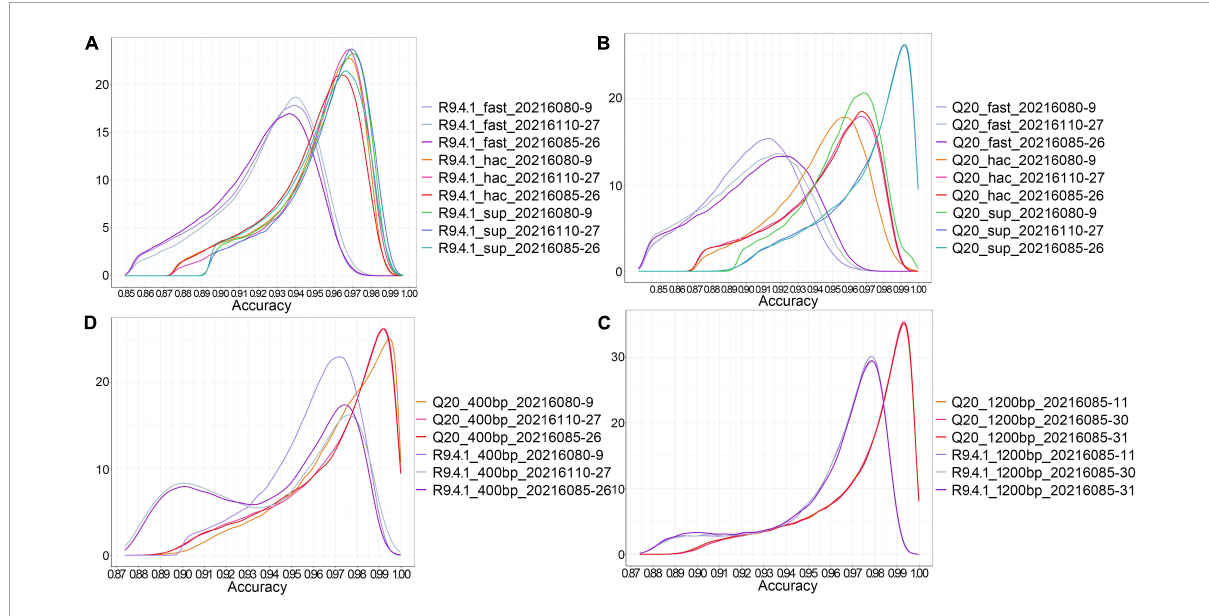
FIGURE1 The effect of different base calling strategies on the accuracy of nanopore sequencing. (A) The density distribution of sequence accuracy corresponding to three data conversion modes (fast, hac, and sup) in method B; (B) The density distribution of sequence accuracy corresponding to three data conversion modes (fast, hac, and sup) in method A; (C) The density distribution of sequence accuracy of the 400 bp targeted amplicons sequenced by method A and method B in the sup mode; (D) The density distribution of sequence accuracy of the 1200 bp targeted amplicons sequenced by method A and method B in the sup mode.